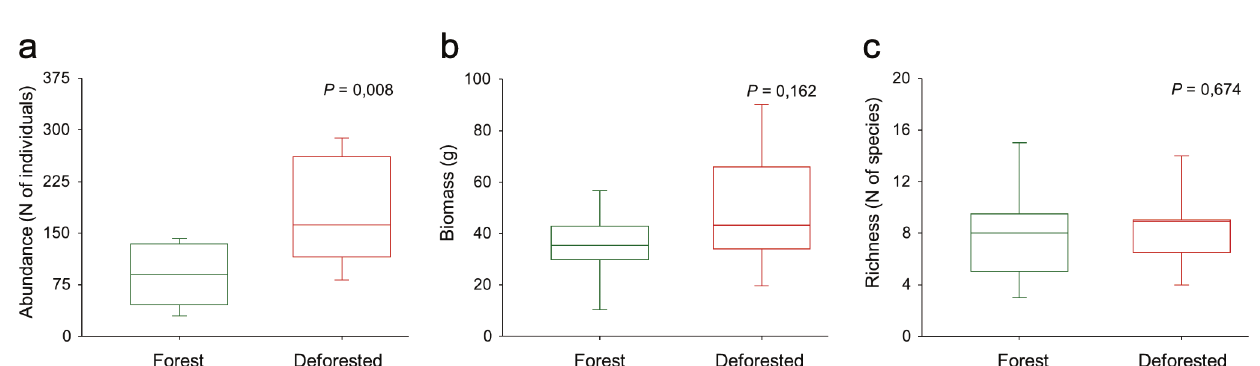
Fig. 2. Catch-per-unit-effort for fishes in forest (n=9) and deforested (n=9) first-order stream reaches in the Upper Xingu River Basin. a. Abundance; b. Biomass; c. Richness. Boxes define the 25 th , 50 th (median) and 75 th percentiles, whiskers represent the 10 th and 90 th percentiles. P-values calculated using univariate